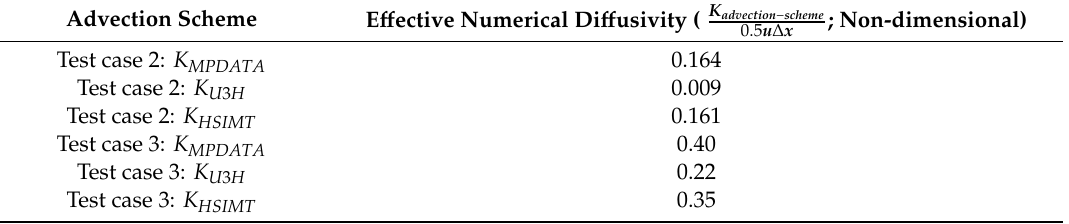
and Test case 3: two-dimensional (2-D) lock